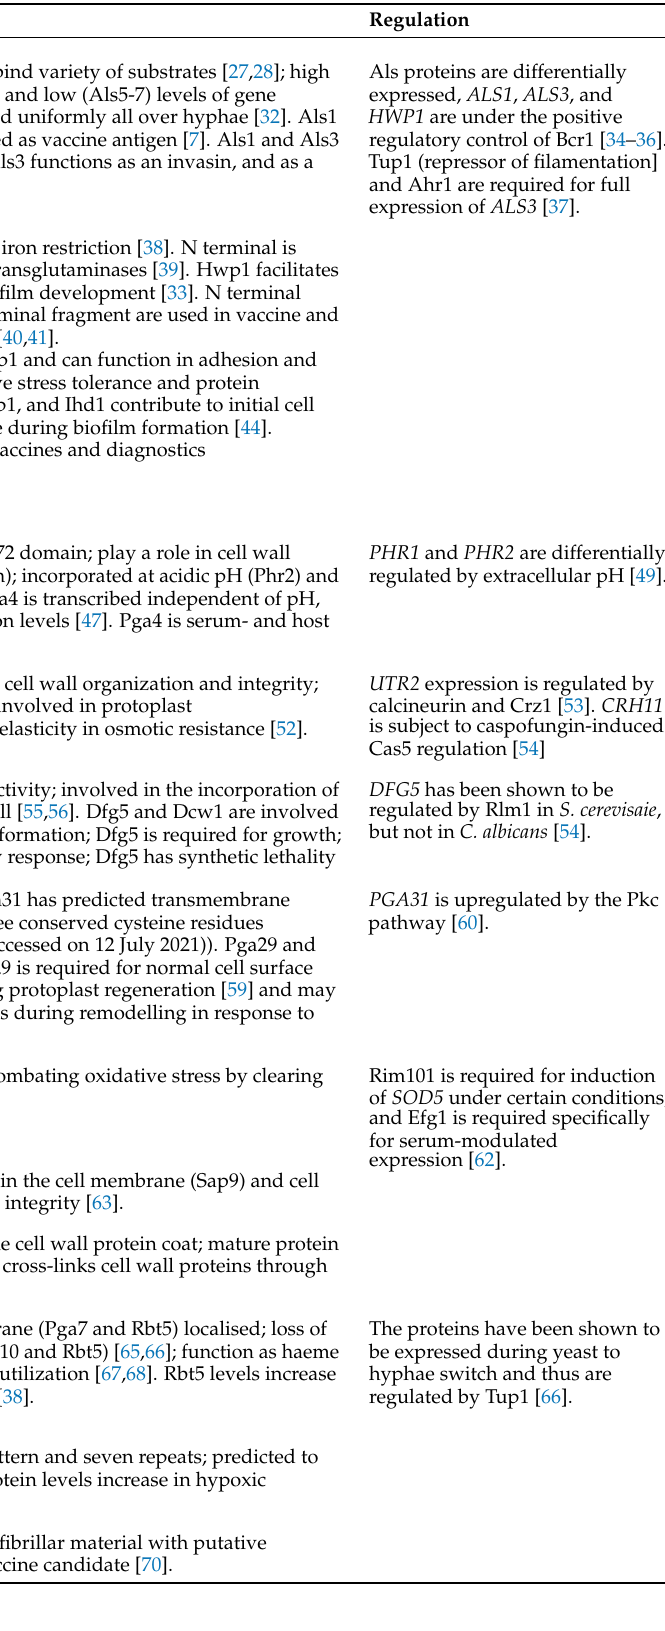
Table 1. Characteristics of specific Candida albicans surface